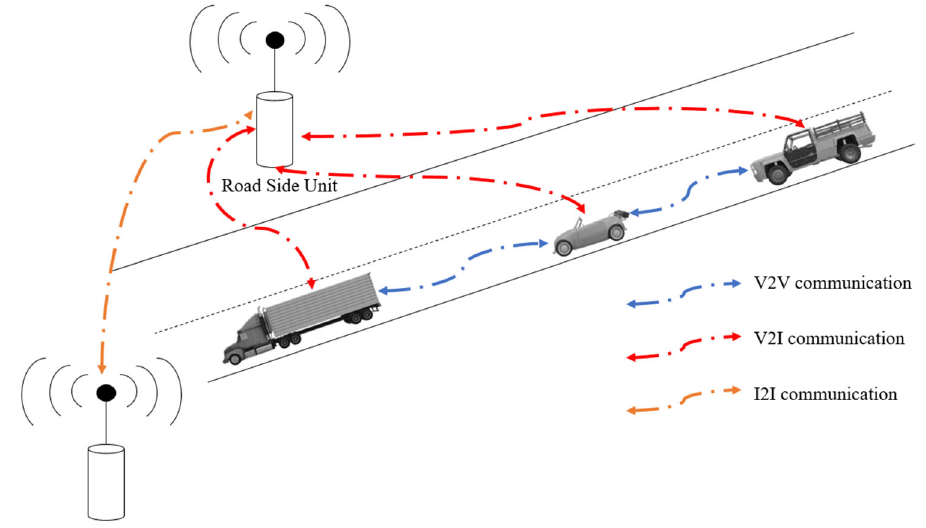
Figure 1. Connected vehicle communications through V2I and V2V.